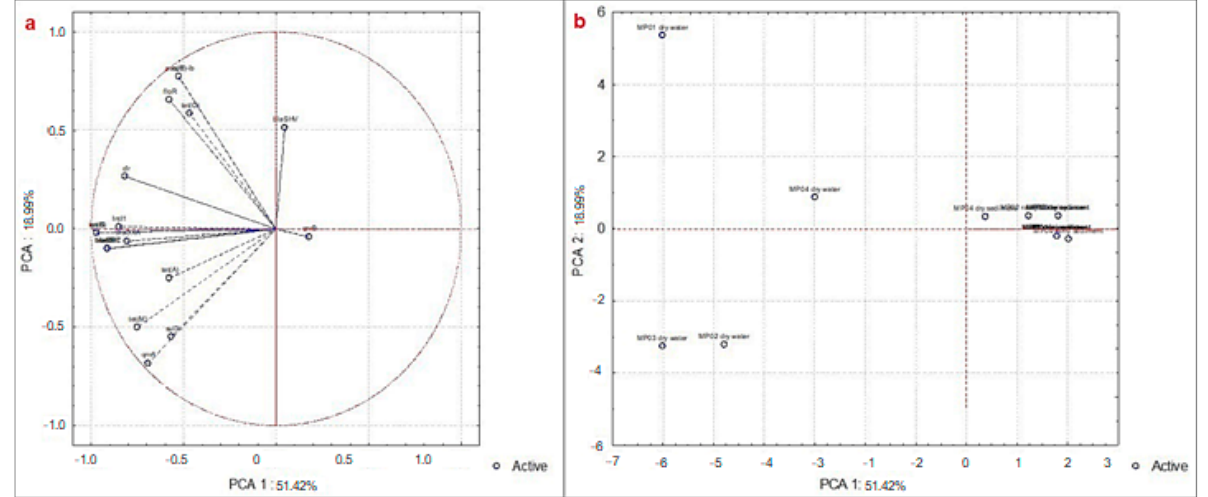
Figure 4. PCA of the presence and absence of ARGs detected in the water and sediments of Meia Ponte River. ( a ) Dot and vector graphics for the ARGs. ( b ) ARBs influence on loads graph at sampling points and their distribution based on this influence.